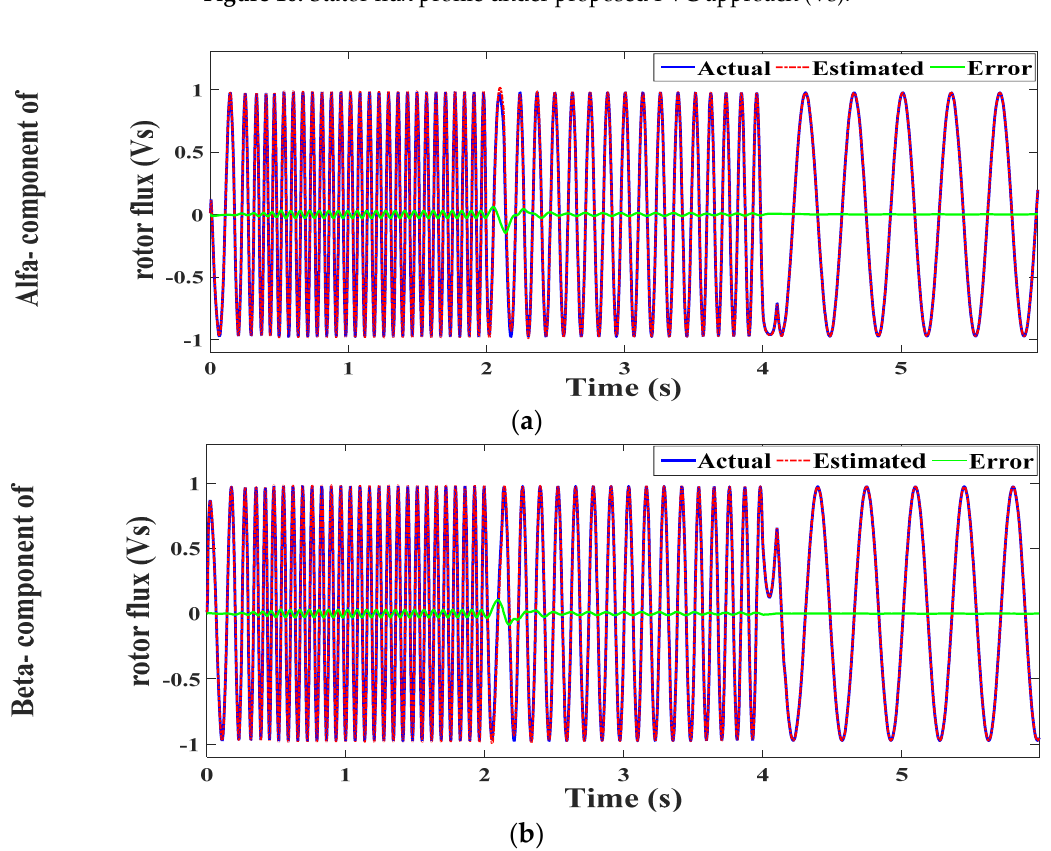
Figure 17. ( a ). Alfa-component of rotor flux under proposed PVC approach (Vs), ( b ). Beta-component of rotor flux under proposed PVC approach (Vs).